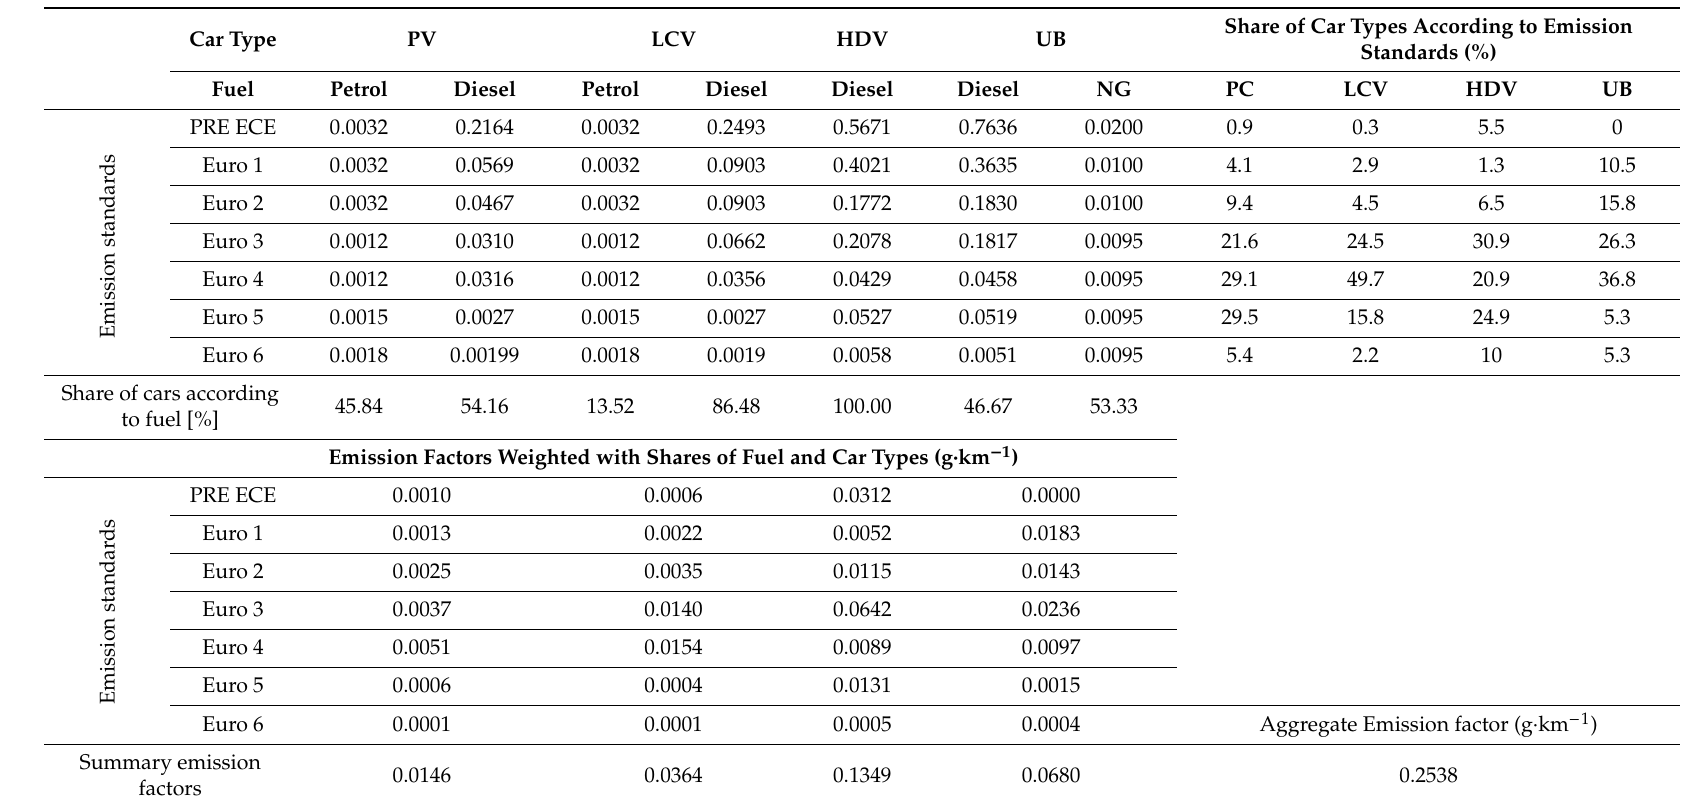
Table 1. Determination of the total emission factor of one car by EMEP methodology, according to emission standards and fuel